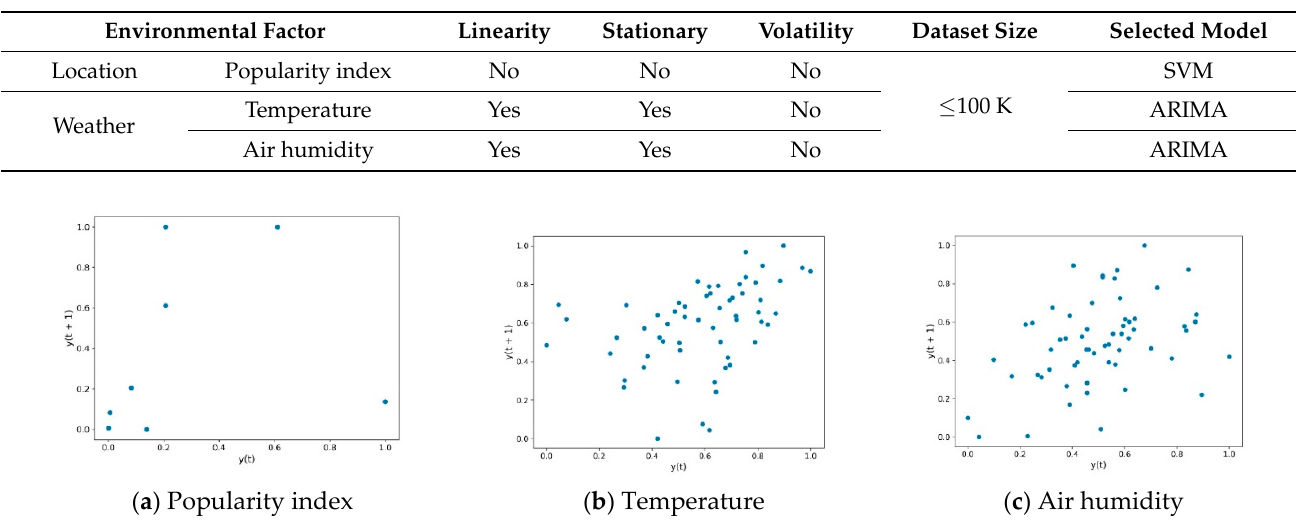
Table 12. Data characteristics tests and results.